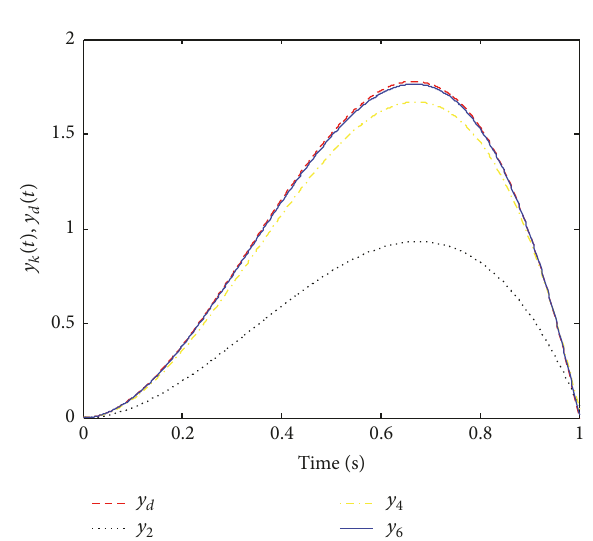
Figure 5: System outputs of (𝐼 2 ) .